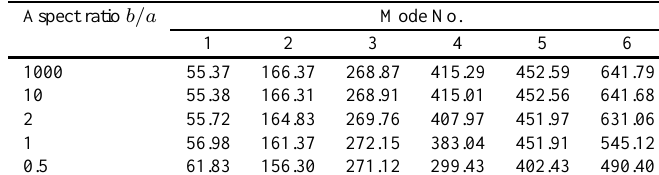
Table 3 Natural frequencies (in Hz) of Clamped-Free rectangular cross-section beam